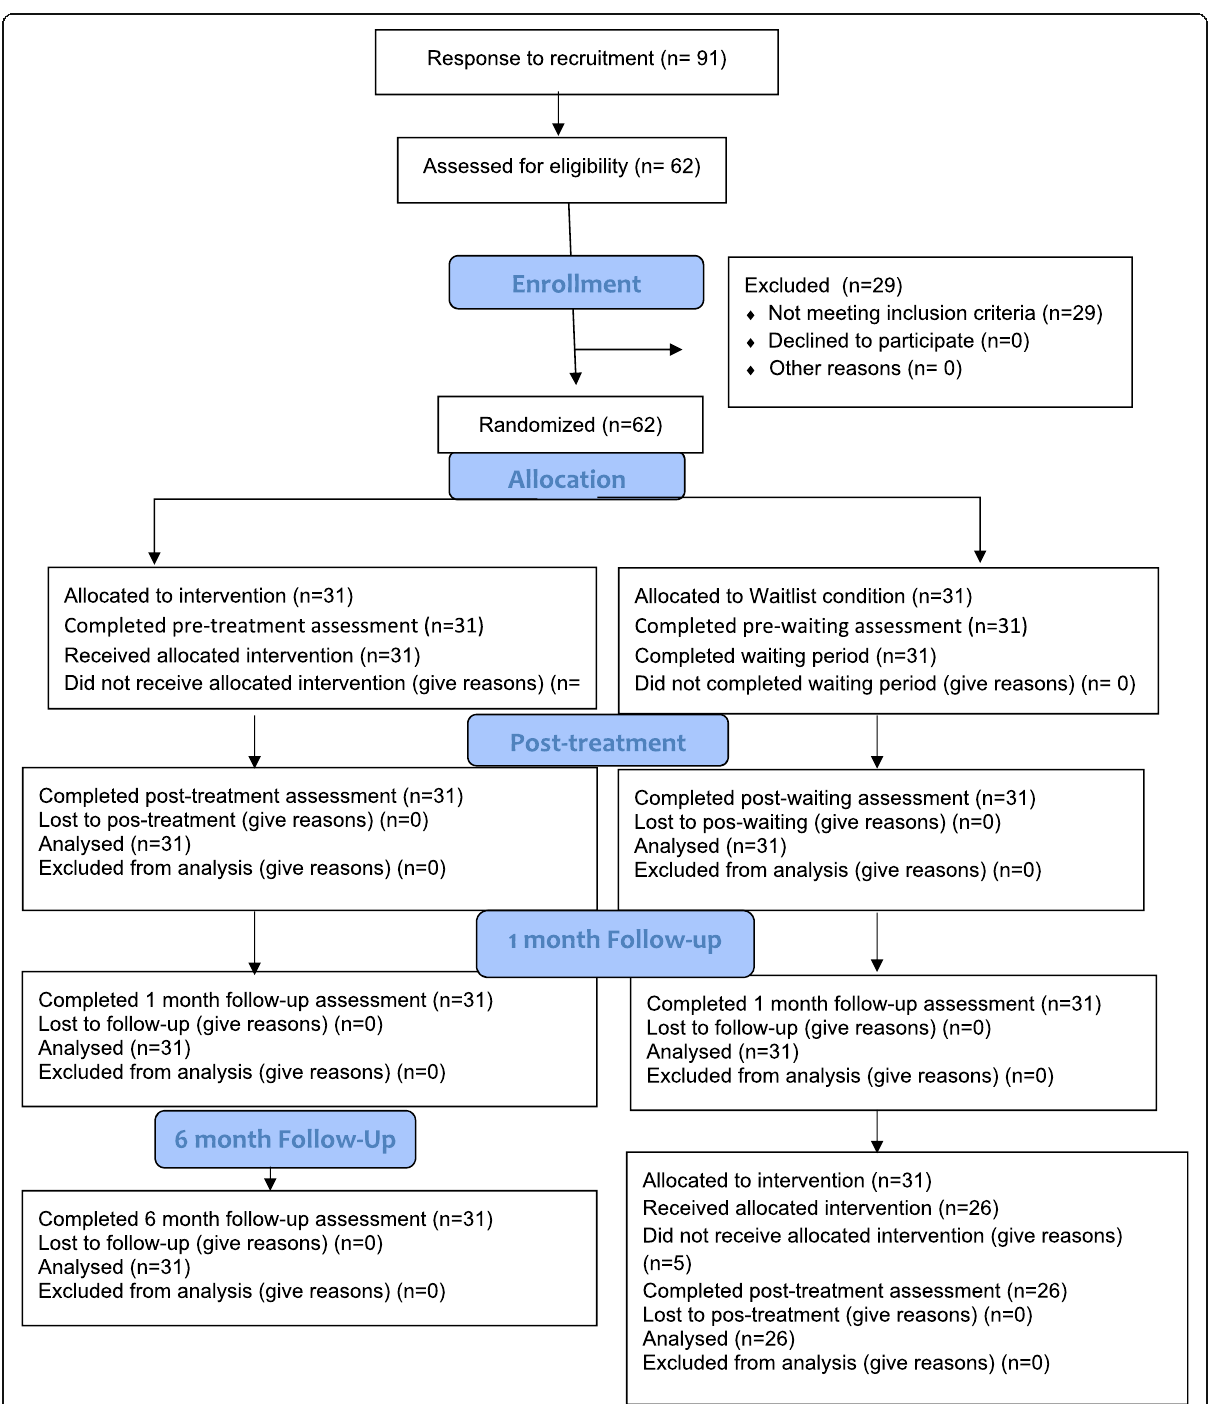
Fig. 1 CONSORT Flowchart Showing the Progression of Participants Throughout the